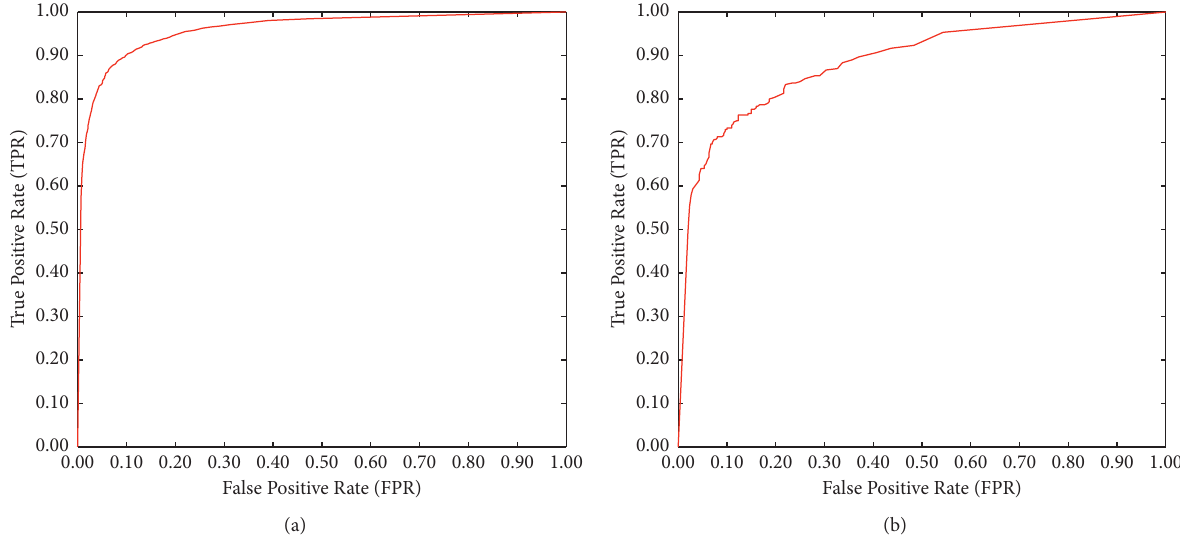
Figure 13: ROCs of CNN-Adam: (a) training phase and (b) testing phase.